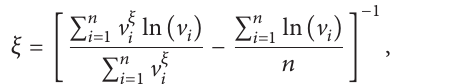
Figure 4: Plot of monthly maximums wind speed distribution over Debuncha for 31 years’